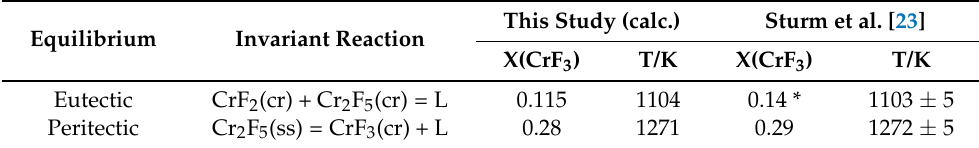
Table 4. Invariant equilibria in the CrF 2 –CrF 3 system.